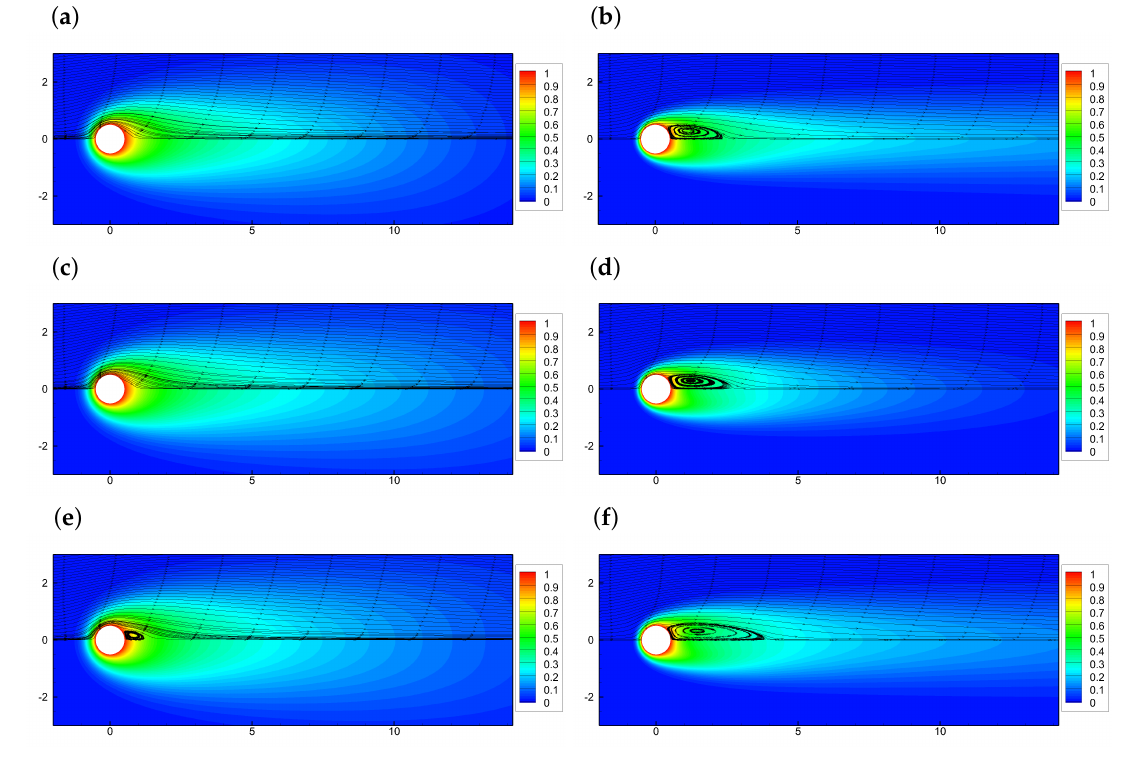
Figure 6. Instantaneous temperature contours at Pr = 1.0. ( a ) Re = 10, n = 0.8; ( b ) Re = 40, n = 0.8; ( c ) Re = 10, n = 1.0; ( d ) Re = 40, n = 1.0; ( e ) Re = 10, n = 1.4; ( f ) Re = 40, n =